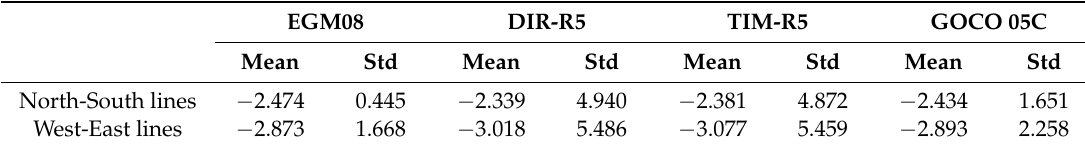
Table 2. Statistics of crossover error analysis in Louisiana.